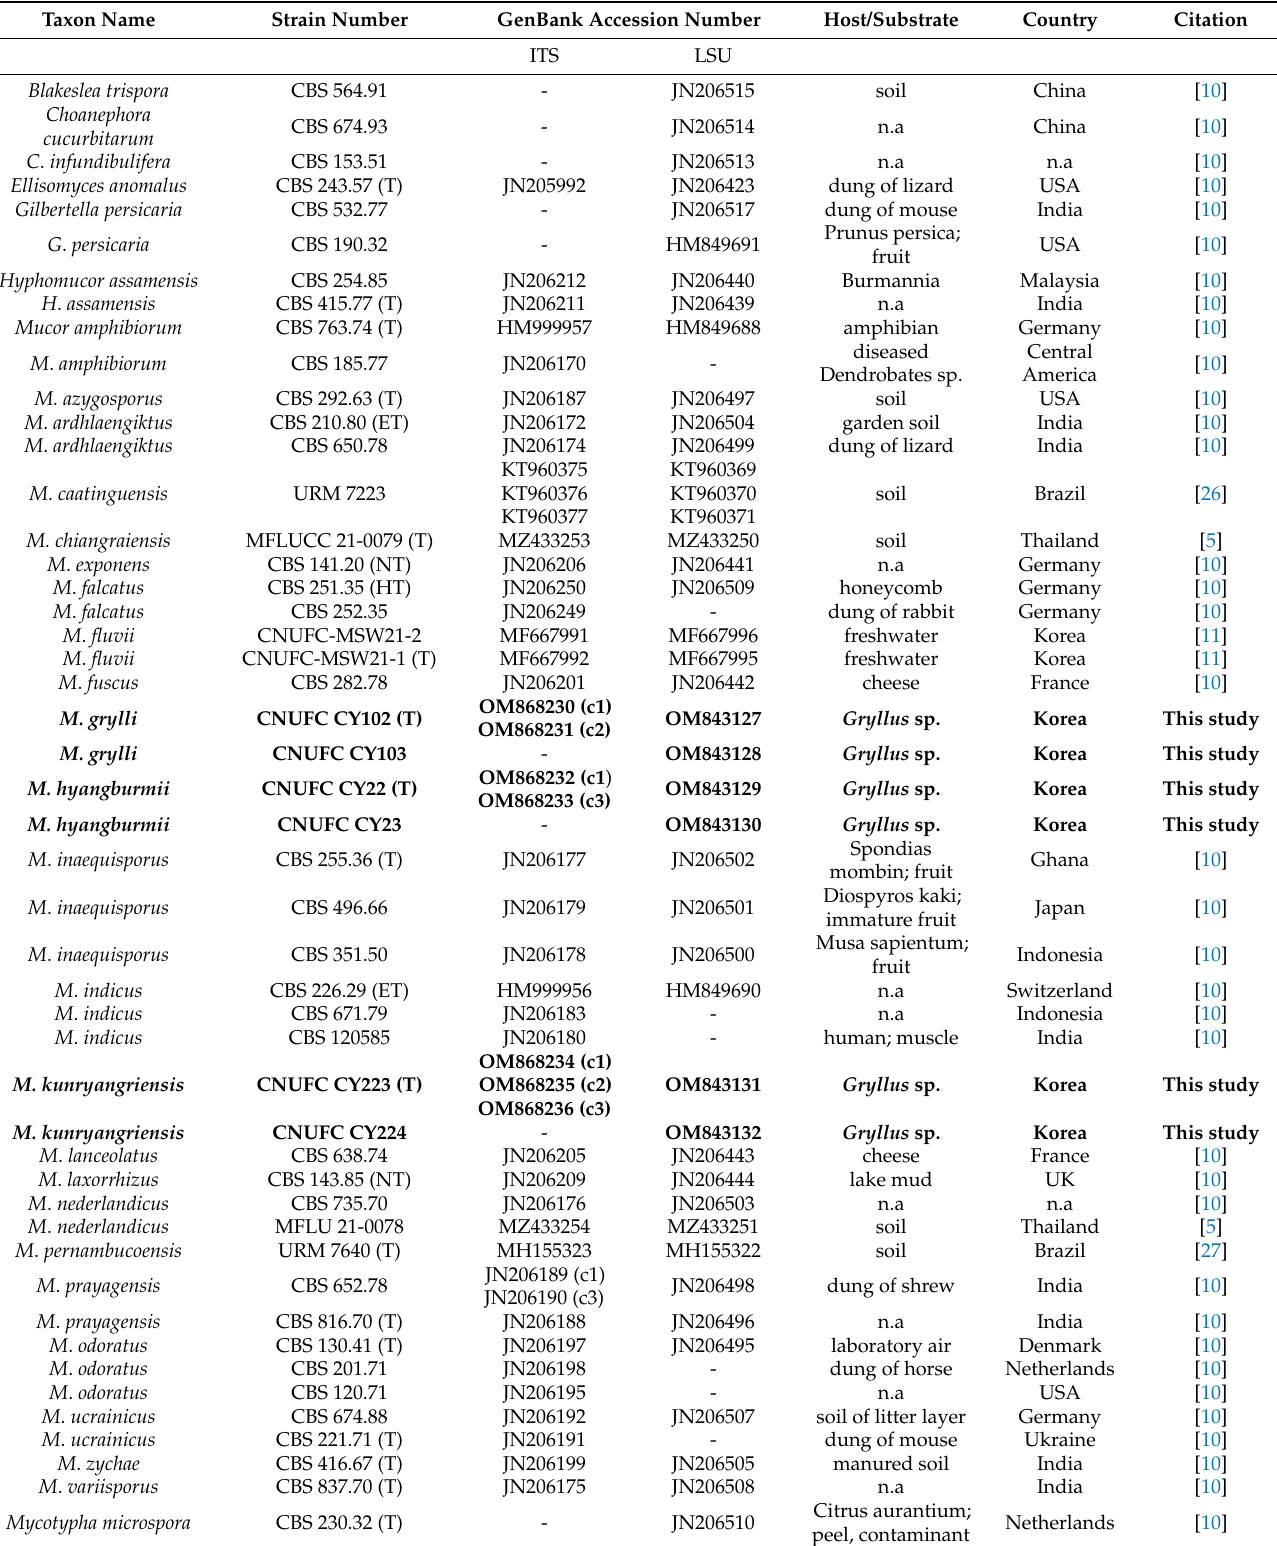
Table 1. Taxa, collection numbers, and GenBank accession numbers used in this